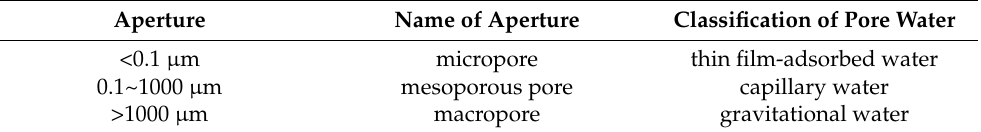
Table 4. Pore classification.